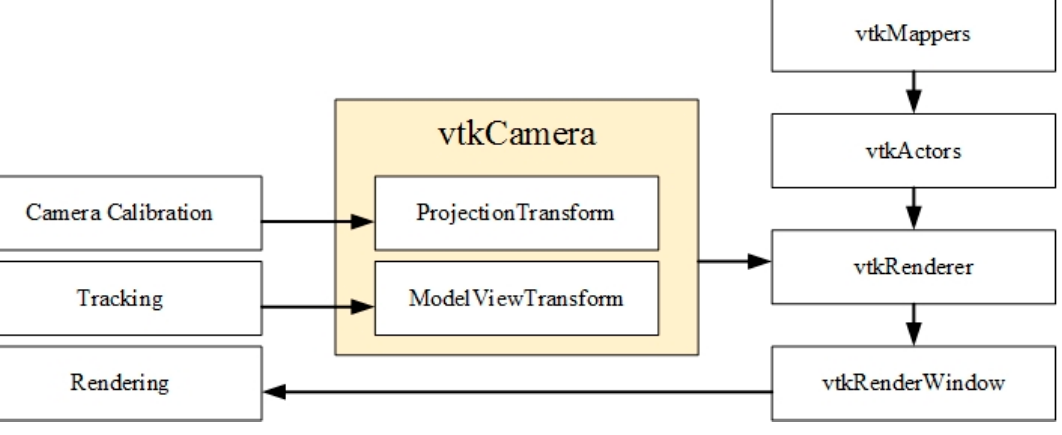
Figure 5. Integration of AR and VTK [41].